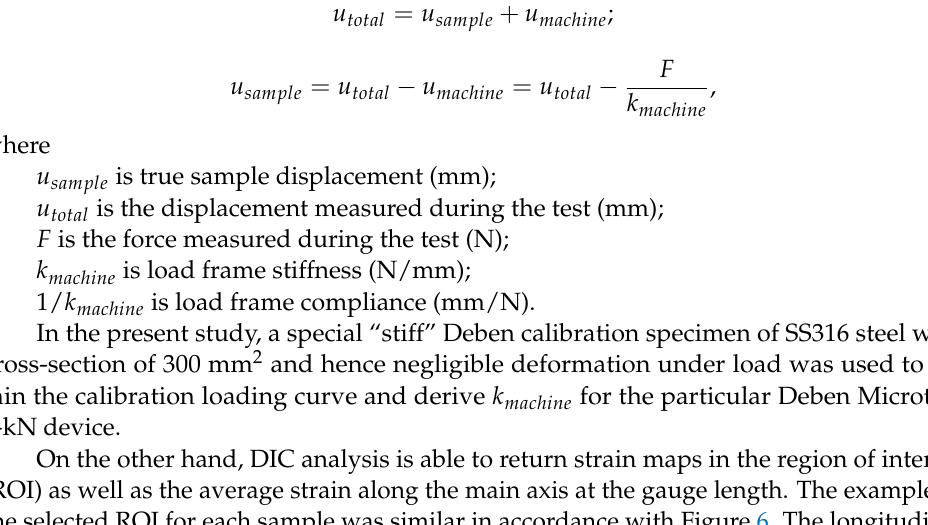
Figure 6. Illustration of typical ROI (Region Of Interest) selection for captured SEM